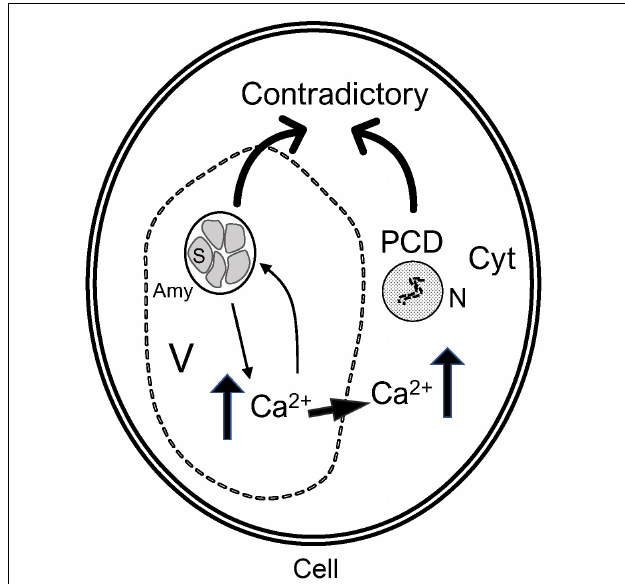
FIGURE 8 | Patterns of interaction between the amyloplasts and Ca 2 + inducing bitter pit in fruits. The low cytoplasmic Ca 2 + concentration of fruits affects the degradation of amyloplasts, and amyloplasts disrupt the distribution of Ca 2 + in cells, thereby causing metabolic disorders. Amy, amyloplast; S, starch granule; V, vacuole; Cyt, cytoplasm; N,